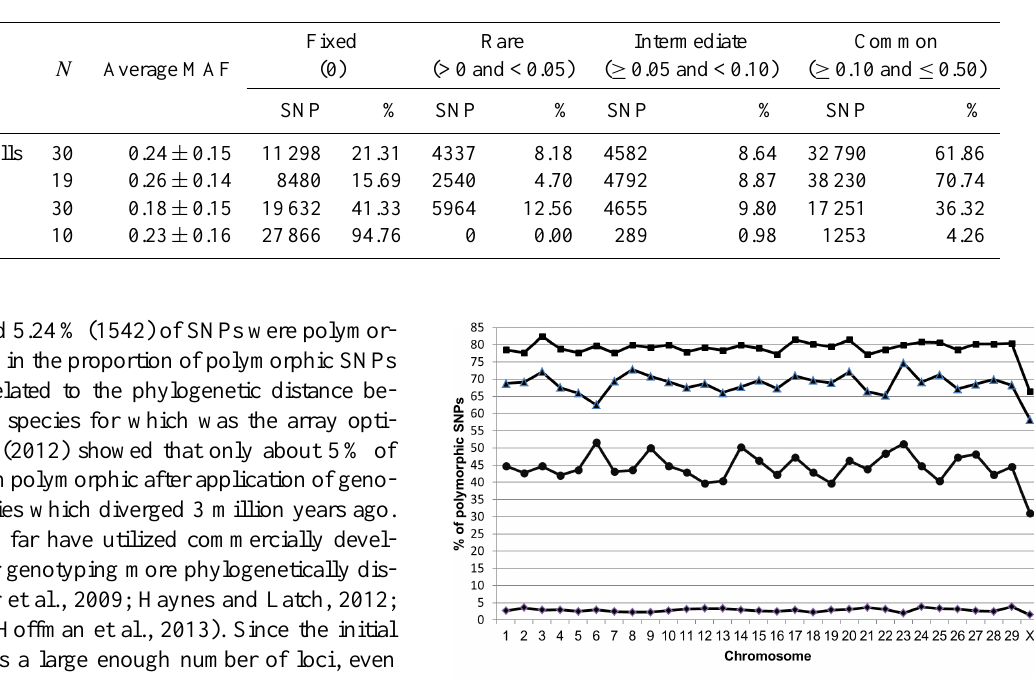
Table 1. MAF distribution of BovineSNP50 BeadChip in analysed groups.